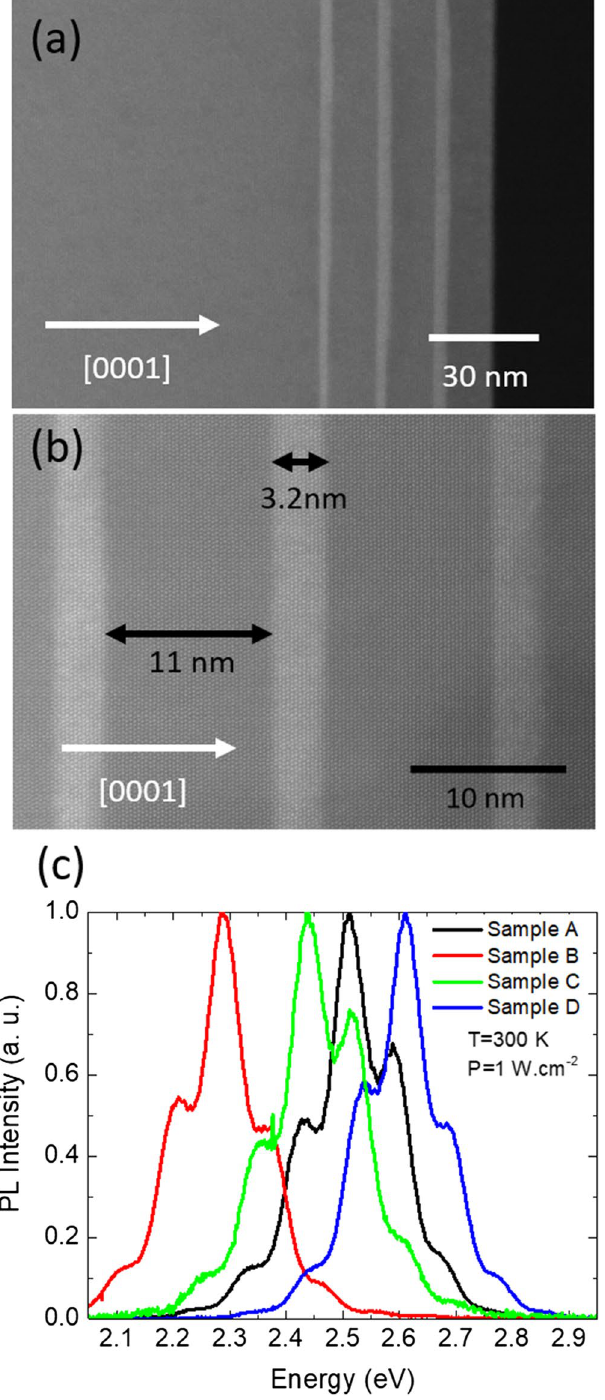
Figure 1. ( a ) HAADF-STEM Images of the InGaN/GaN MQWs of sample B. InGaN and GaN appear as bright and dark respectively. ( b ) High resolution image taken along the 11–20 zone axis. ( c ) RT-PL measurement of the four InGaN/GaN MQWs layers at P = 1 W cm −2